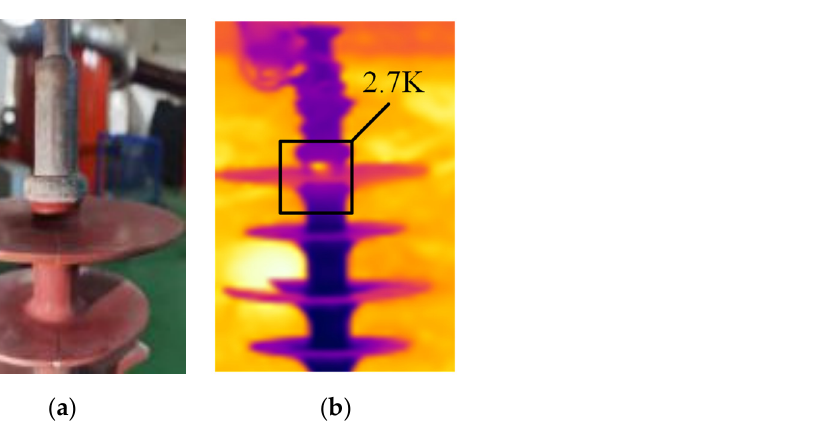
Figure 5. Temperature rise in sample #1 after removing surface contamination: ( a ) contamination cleaning; ( b ) temperature rise image.